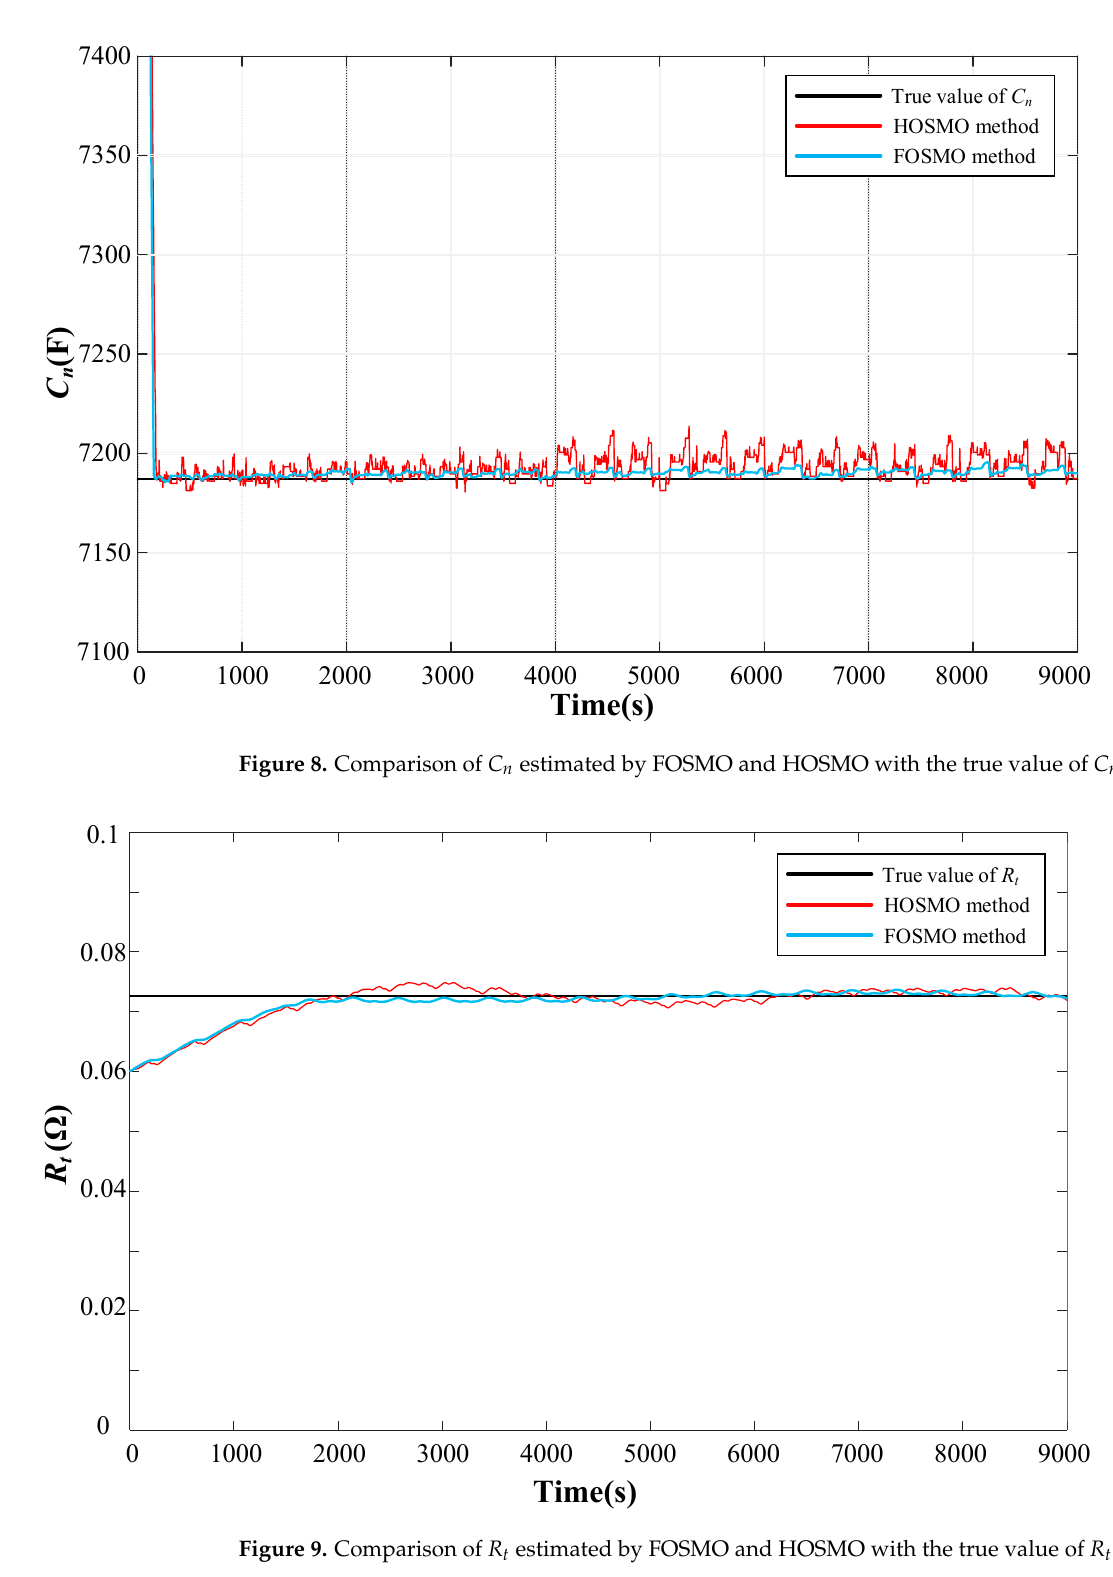
Table 3. The measurement error in SoH estimation.